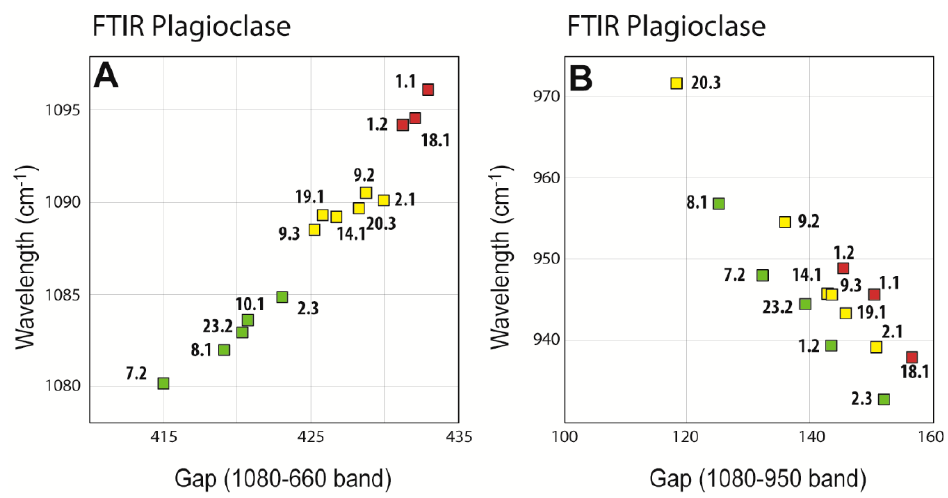
Figure 11. Bivariate diagrams of main peak position in the FTIR spectra, with their correlation coefficients. ( A ) Bivariate diagram of peak position and the gap between peak bands 1080–660 nm. ( B ) Bivariate diagram of the same peak position as in A and peak bands 1080–950 nm; green, maskelynite FTIR spectra type A; yellow, maskelynite FTIR spectra type B; red, maskelynite FTIR spectra type C.